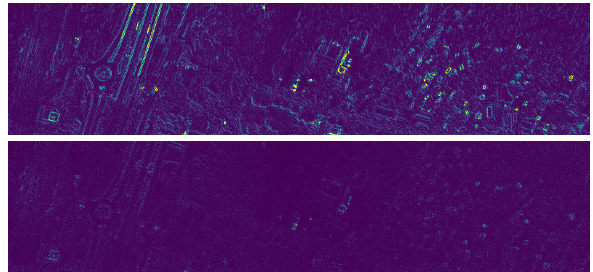
Figure 3. Residual difference in the overlap region after the alignment of two consecutive SkySat L1B scenes of the same push-frame strip. Top to bottom: using the initial transform H i , using the refined transform ˆ H i . The same scaling and colormap have been used for both